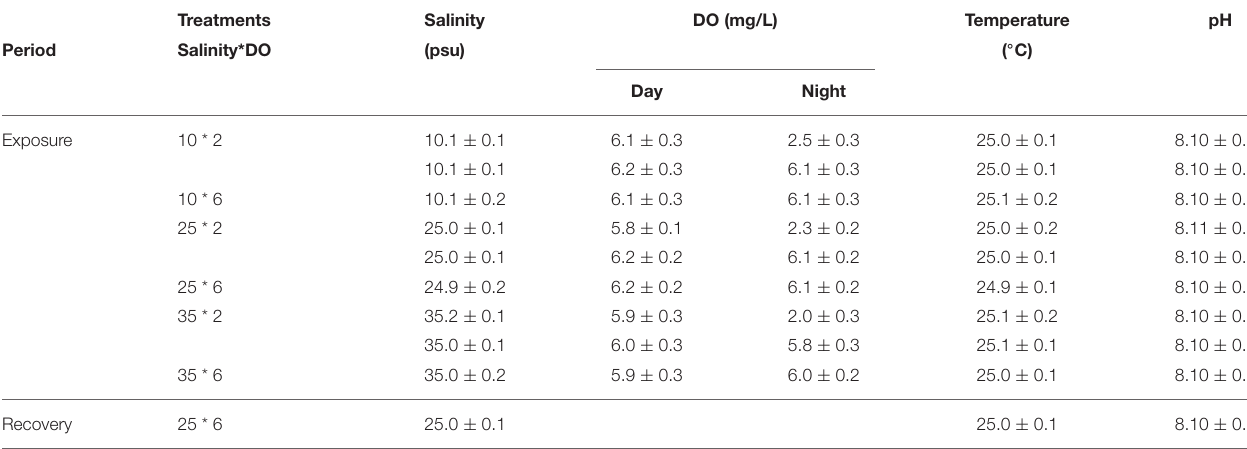
TABLE 1 | Chemistry (mean ± SD) variables of seawater for the experiment.